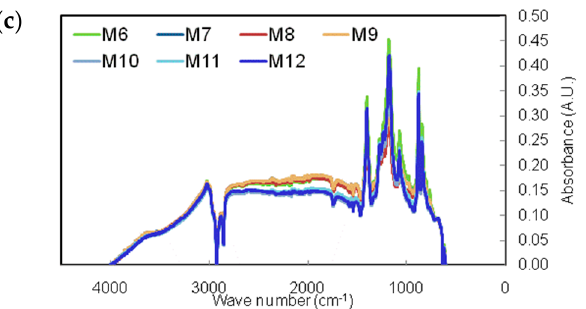
Figure 4. FT ‐ IR spectra of the PVDF membranes before and after silane modification